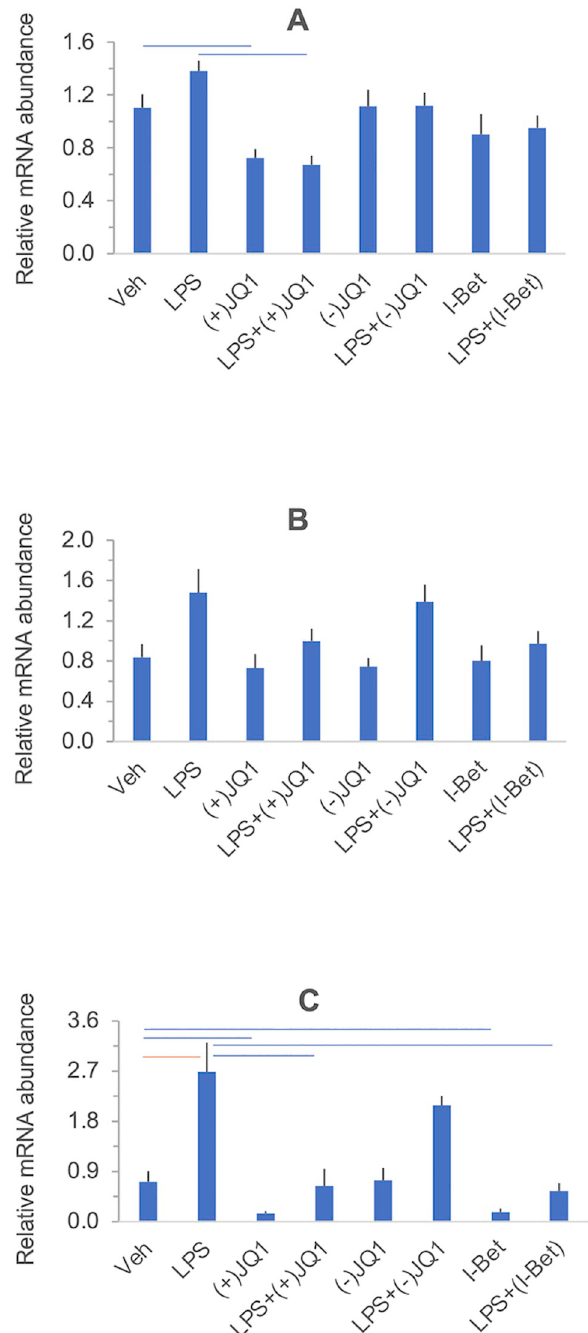
Fig 2. The effect of LPS and BET inhibitors on PTGS1 (Panel A), PTGES (Panel B) and PTGS2 (Panel C) mRNA expression in DSCs. Sub-confluent primary DSC cultures were treated with vehicle, LPS, (+)-JQ1, (-)-JQ1, I-BET-762, and their combinations as indicated under the columns. Messenger RNA abundance was determined by qRT-PCR. Further details of the experimental procedures and data analysis are described in the Materials and methods. Columns show the mean ± SEM, n = 4–5 independent experiments. Significant differences (at 5% FDR), highlighted in the heatmap in Fig 1, are indicated by the horizontal orange and blue lines. The results of the individual experiments and summary statistics are presented in the S1